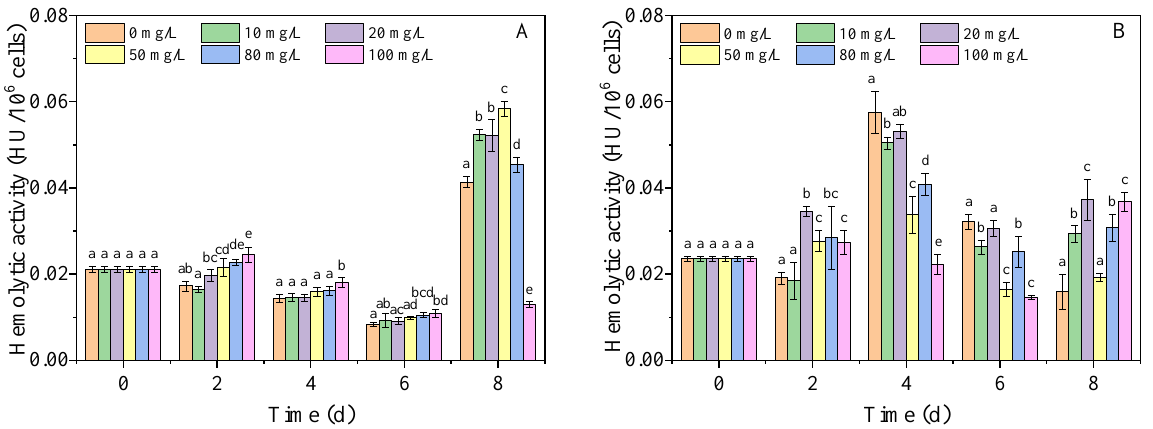
Figure 5. Hemolytic activity of extracellular toxins ( A ) and intracellular toxins ( B ) in different concentrations of nano-PS groups. Different letters represent significant differences ( p <